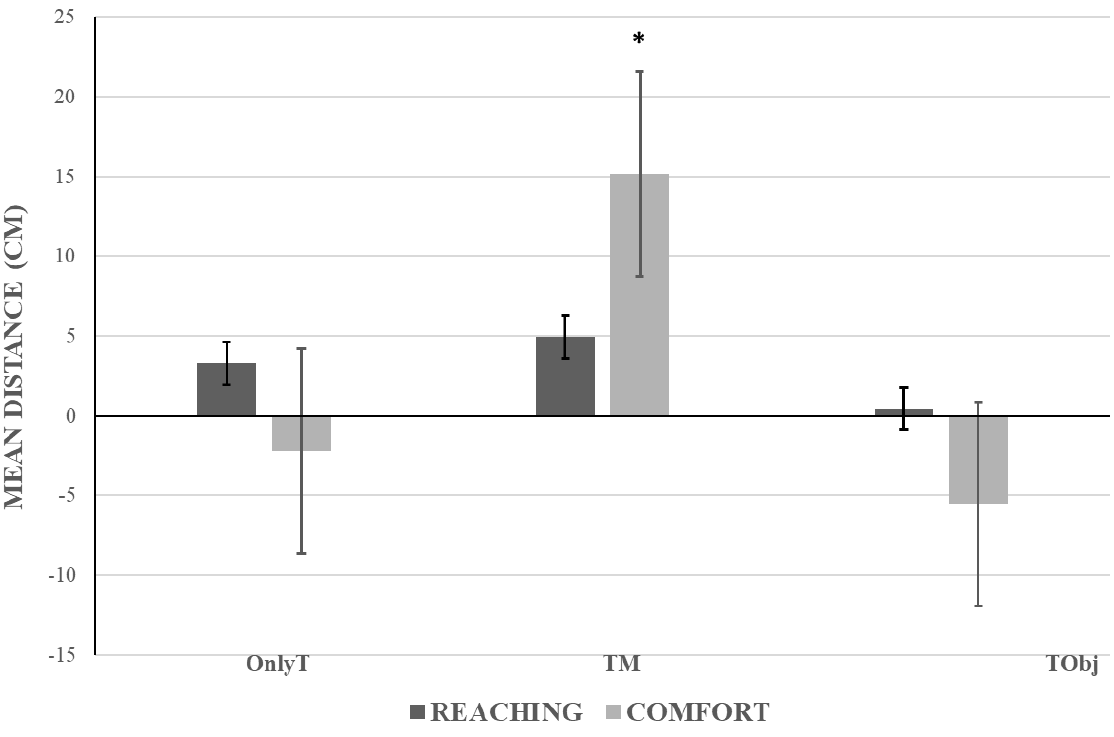
Figure 4. Interaction Group × Task. The graph shows the mean distance (in cm) as a function of the three groups (OnlyT: Only Tool; TM: Tool plus Mannequin; TObj: Tool plus Object) and the reaching- and comfort-distance tasks. The asterisk indicates the experimental condition that differ significantly from all others. More specifically, the comfort distance in the TM group was significantly different from the comfort distance in the OnlyT and TObj groups and from the reaching distance in all three groups. Error bars represent the standard error.